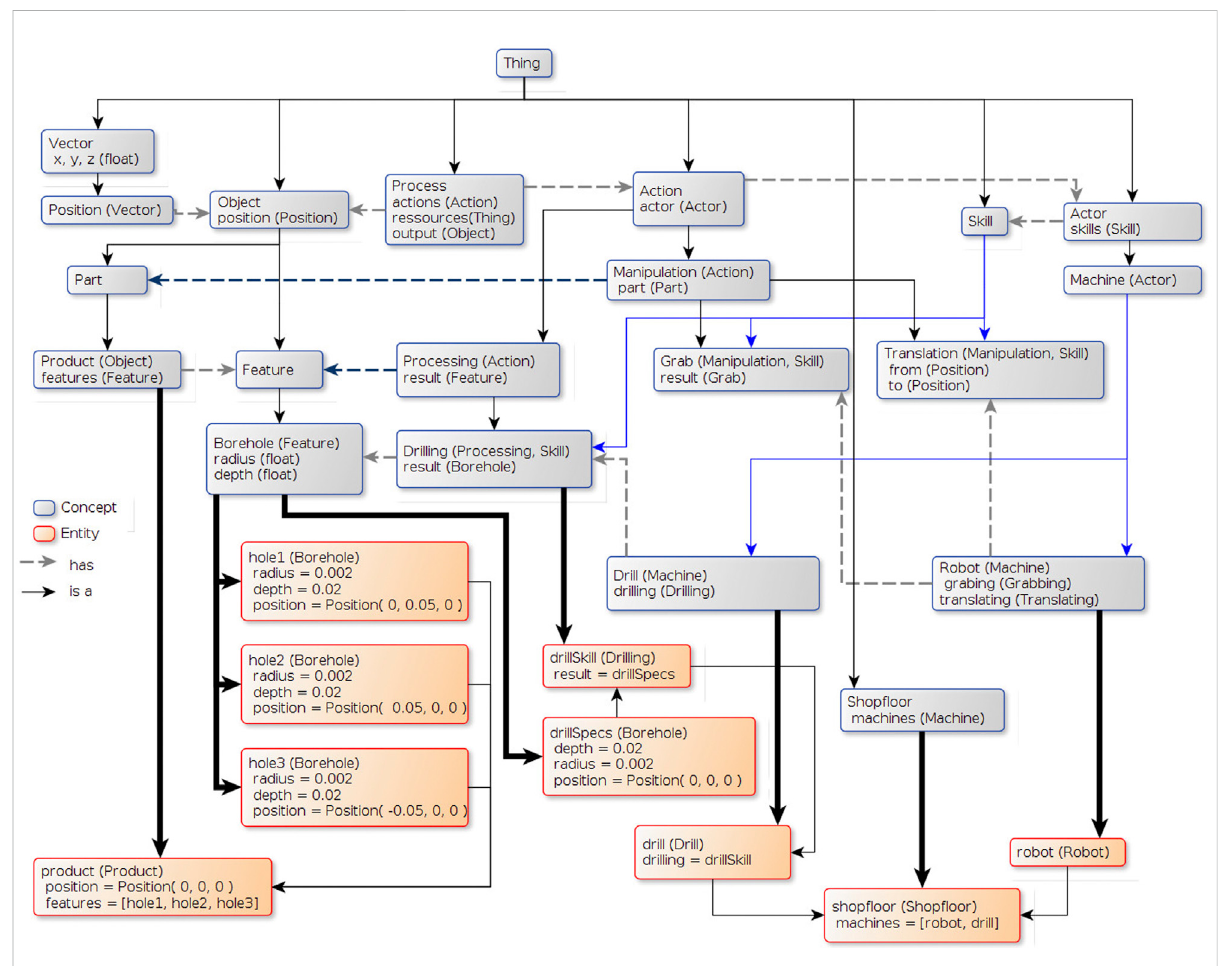
FIGURE 12 Semantic layer of a simple scene, gray boxes are the taxonomy concepts and the orange boxes the ontology entities.